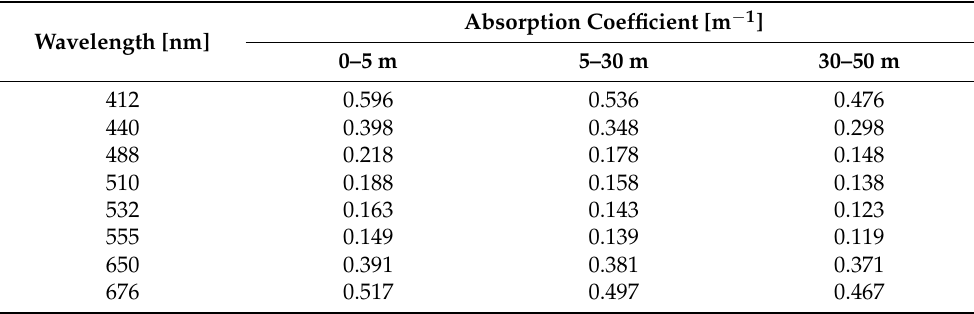
Figure 2. The southern Baltic Sea area for which an optical model of the sea was made. Table 1. The absorption coefficient used in the sea environment optical model [25].